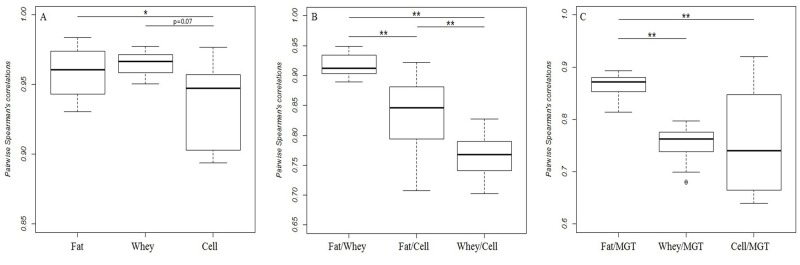
MiRNome homogeneity within milk fractions (A), miRNome similarity among milk fractions (B) and miRNome similarity of milk fractions with mammary gland tissue (C) using Spearman’s correlations.Fat: milk fat; Cell: milk somatic cells; MGT: mammary gland tissue.